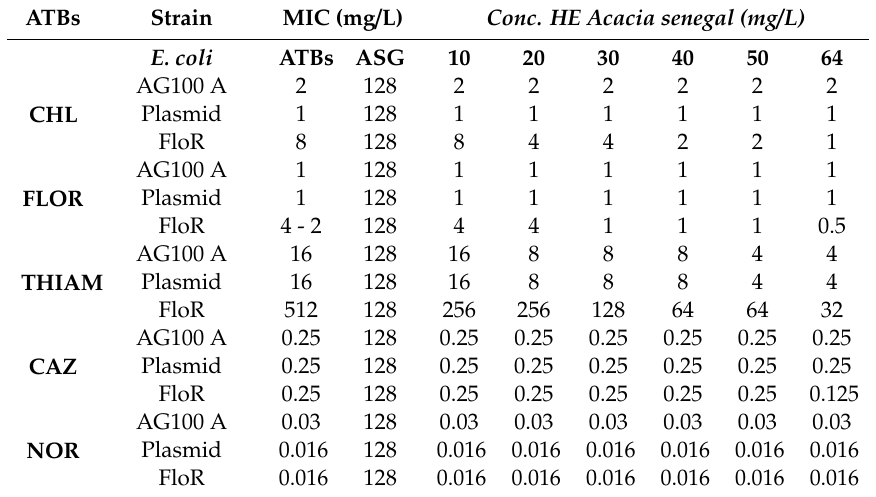
Table 7. FloR expression and phenicols susceptibility in absence or in presence of HE extract. ATBs Strain MIC (mg / L) Conc. HE Acacia senegal (mg / L) E. coli ATBs ASG